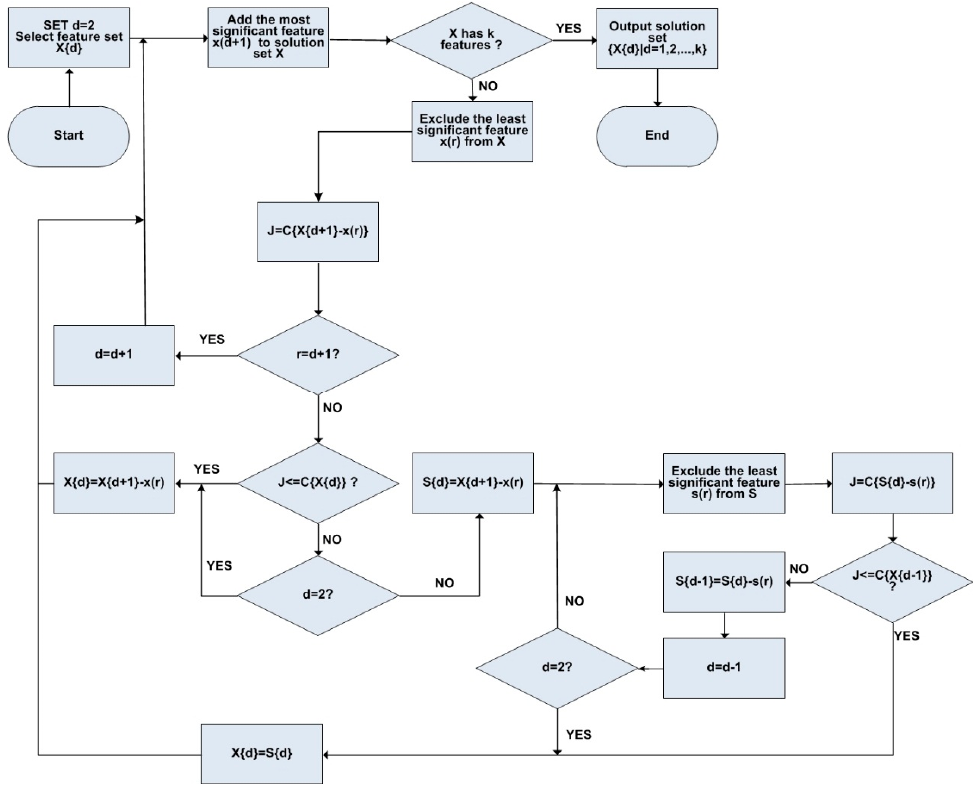
Figure 9. Flowchart of the SFFS method.